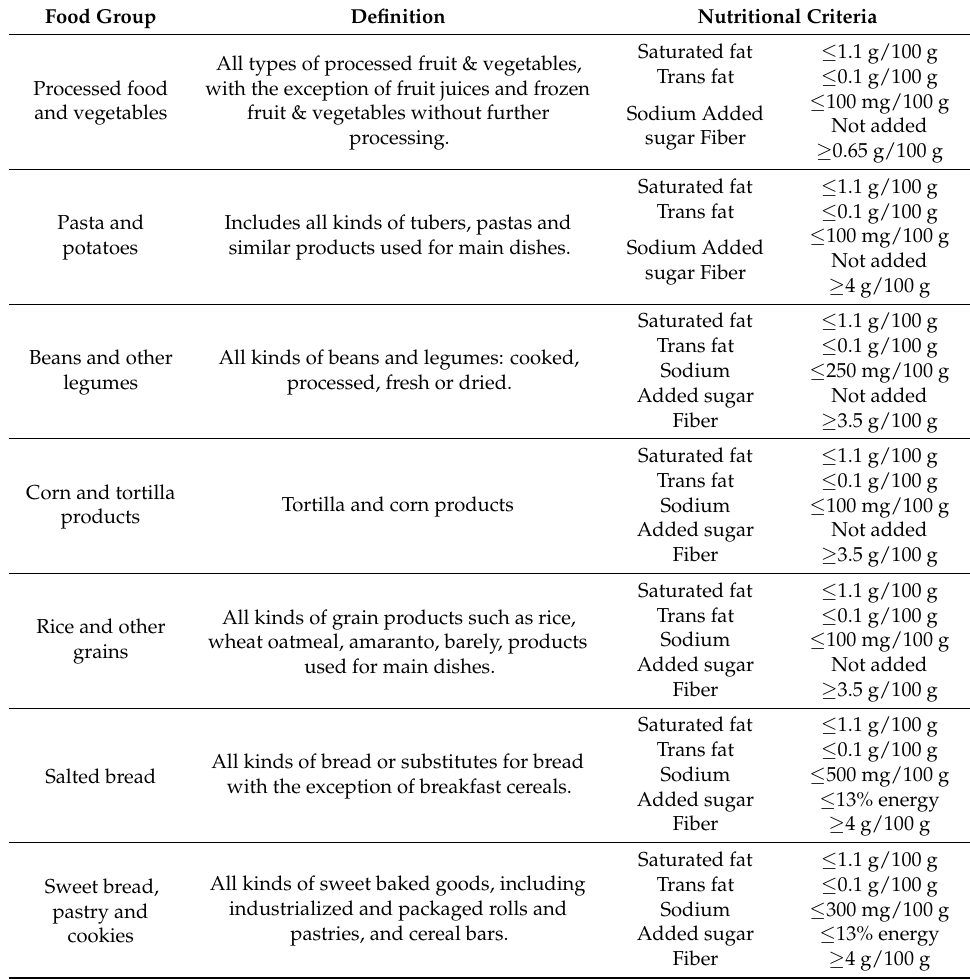
Table A1. Front-of-package (FOP) nutrition labeling criteria of the Mexican Committee of Nutrition Experts